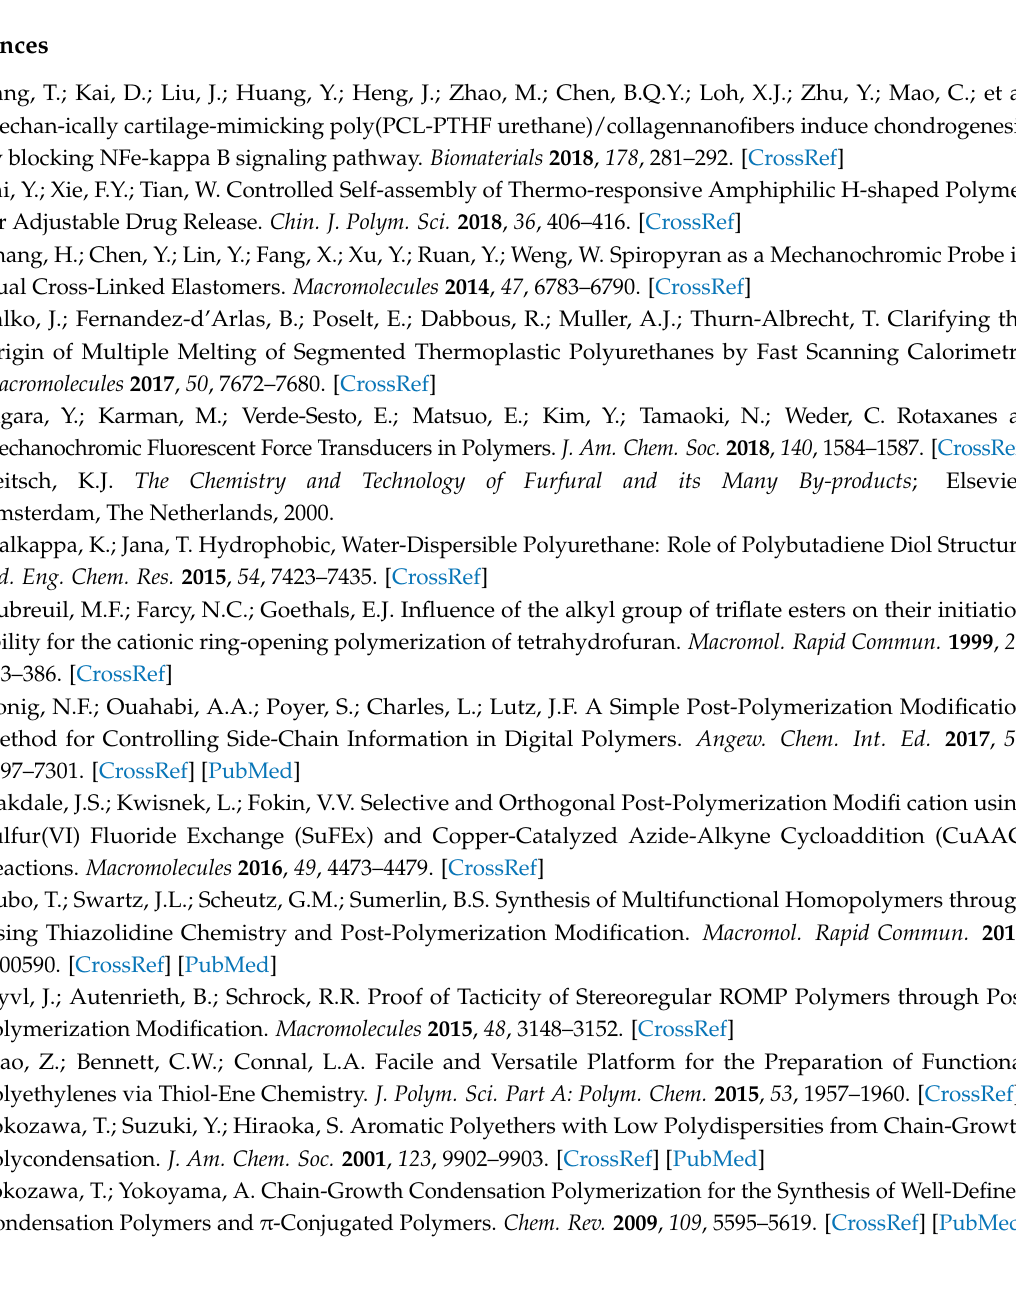
Figure S1: 1 H NMR spectrum of UPTHF ( M n = 4300 g mol − 1 ) in CDCl 3 ; Figure S2: 13 C NMR spectrum of UPTHF ( M n = 4300 g mol − 1 ) in CDCl 3 ; Figure S3: 1 H NMR spectrum of PTHF acid in DMSO- d 6 ; Figure S4: 1 H NMR spectra of PTHF mPEG1 (a) and PTHF mPEG2 (b) in DMSO- d